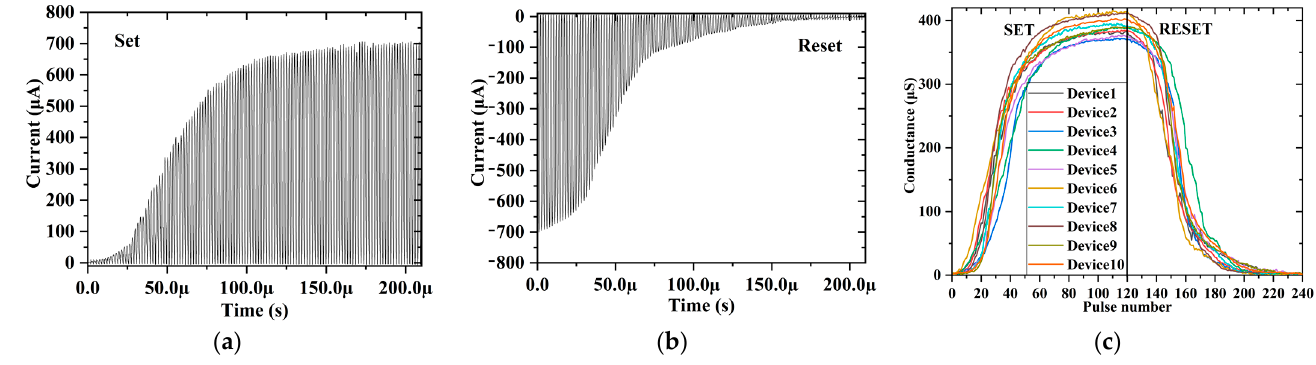
Figure 2. Typical impulse response results of 1T1R unit; 1.8 V/1 µs and − 1.8 V/1 µs voltage pulses were used in ( a ) the SET process and ( b ) the RESET process, respectively. ( c ) The conductivity adjustment curve of multiple units under SET/RESET pulse voltage; reading voltage is 0.2 V.